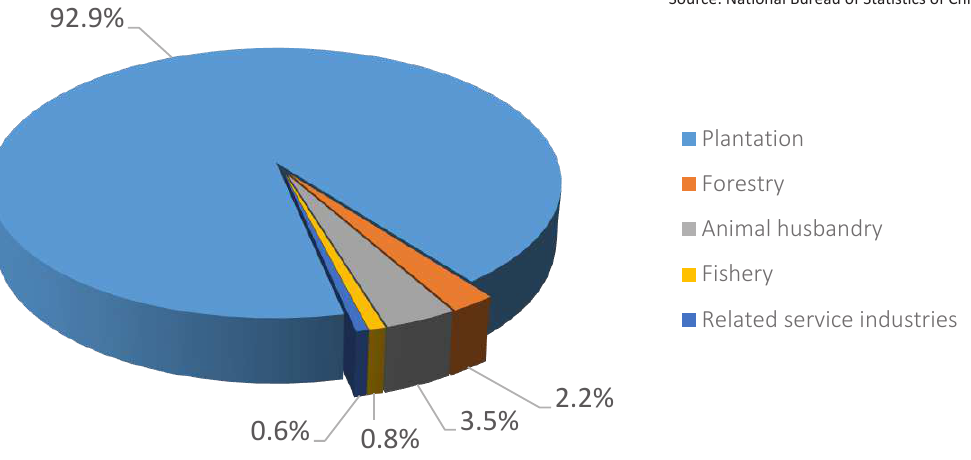
Figure 4. Composition of rural employees in the primary industry